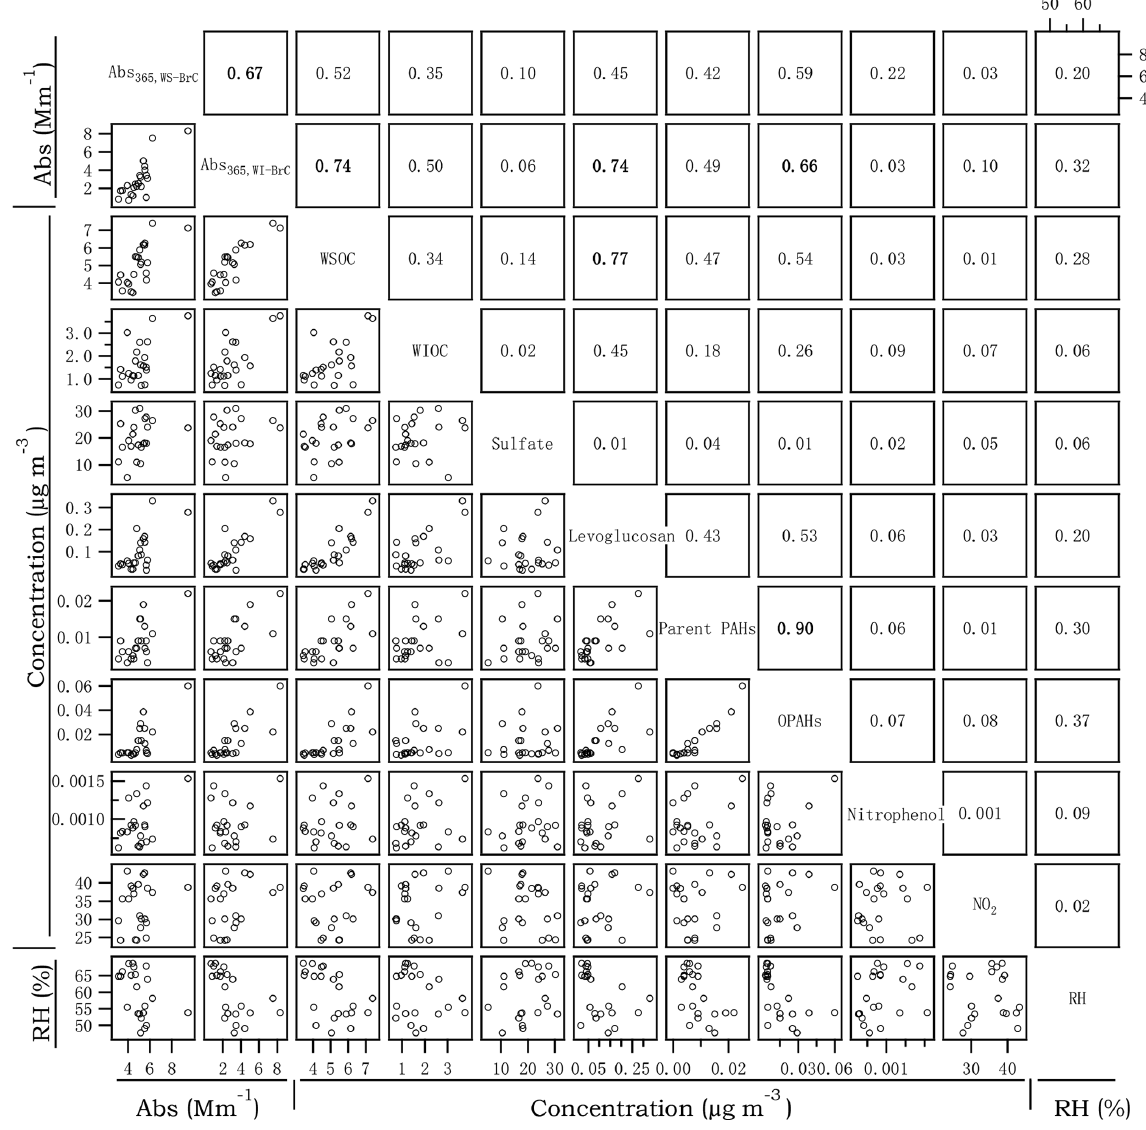
Figure 3. Cross correlations between Abs 365 , WS-BrC , Abs 365 , WI-BrC , selected chemical compositions and RH in summer. The numbers at the upper right denote the linear correlation coefficients ( r 2 ) of the corresponding scatter